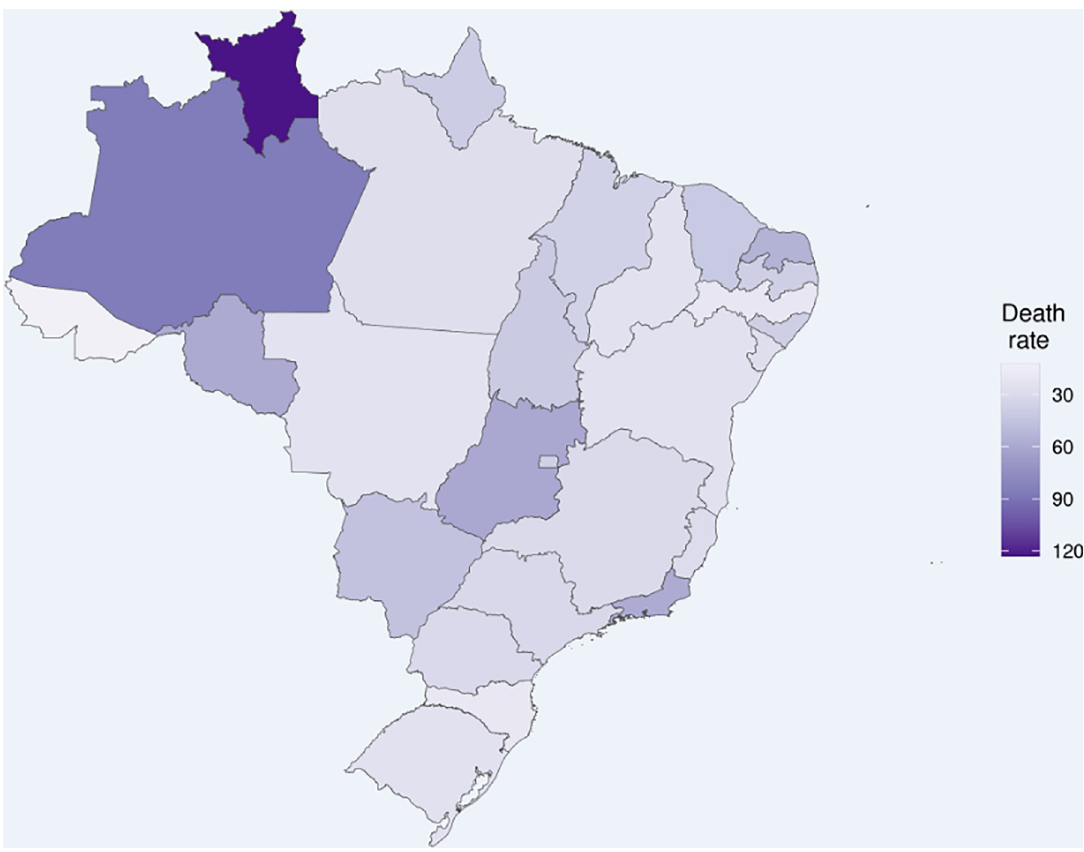
Fig 3. Maternal death ratio by COVID-19 in Brazilian states (elaborated by the authors). Maternal death ratio was calculated using the number of maternal deaths/100,000 live births, which was estimated from the number of live births from 2019 from SINASC database. Each state is colored according to tones of purple according to the shown scale. The number of live births in each state in 2019 was considered for this estimate (http://svs.aids.gov.br/dantps/centrais-de-conteudos/paineis-de-monitoramento/natalidade/nascidos-